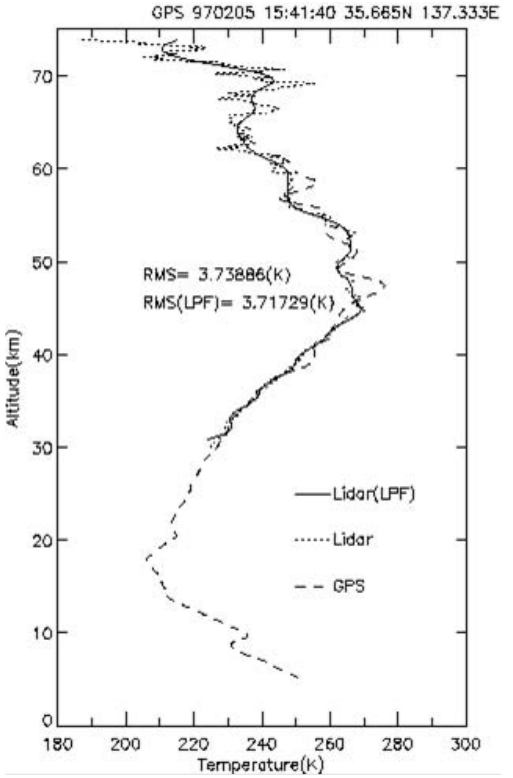
Fig. 10. Comparison of temperature profiles between GPS/MET data (dashed lines) at 15:41UTC, 5 February 1997 at 35.7 ◦ N, 137.3 ◦ E and Rayleigh lidar data (dotted line) between 15:08 and